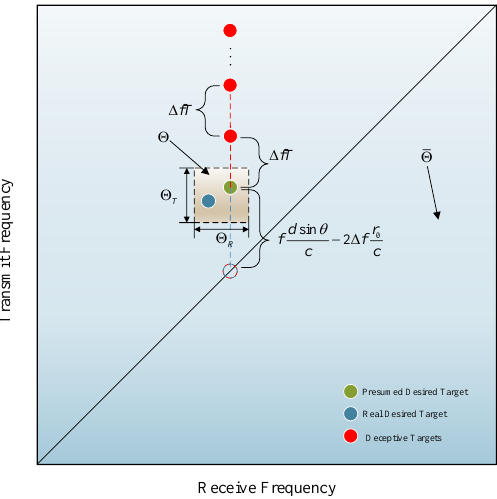
Figure 2. Illustration of DTR in the transmit–receive